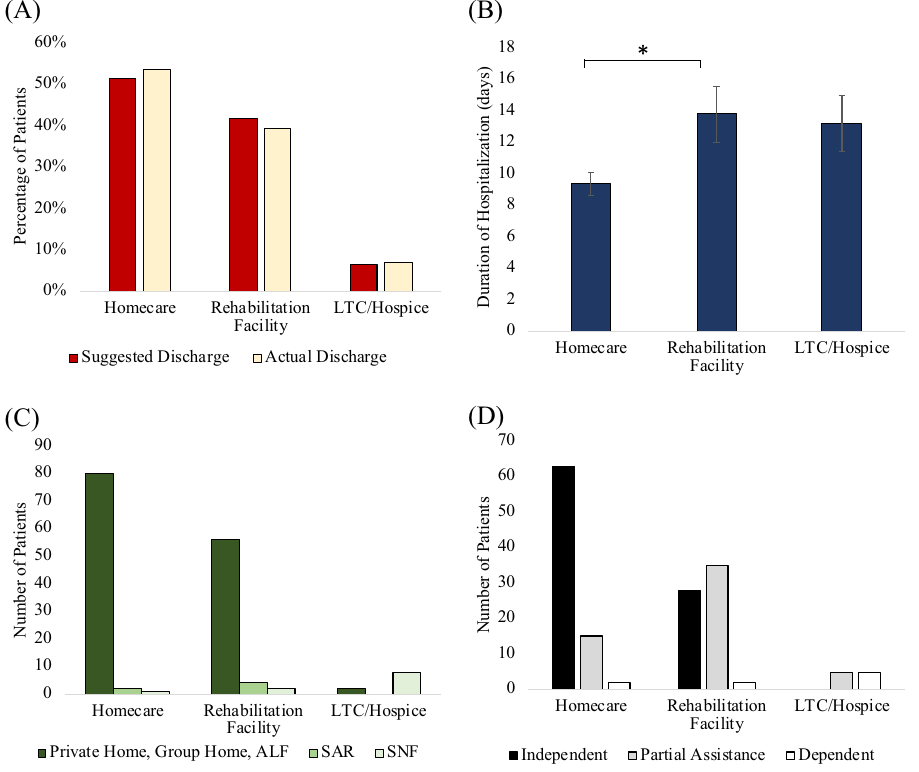
Figure 4. ( A ) Discharge compliance, ( B ) duration of hospitalization versus suggested discharge location, ( C ) pre-admission domicile versus actual discharge location, and ( D ) pre-admission independent status versus suggested discharge location. * indicates p < 0.05 (Chi Square). ALF: assisted living facility, SAR: sub-acute assisted rehab, SNF: skilled nursing facility.